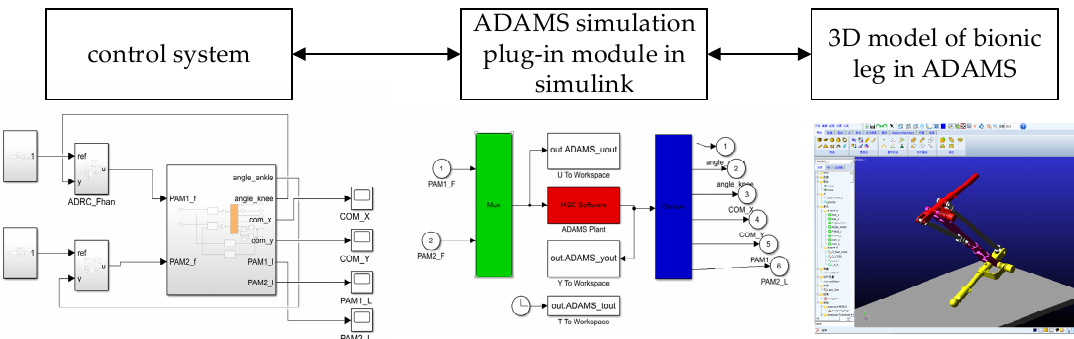
Figure 6. ADAMS–MATLAB co-simulation model.